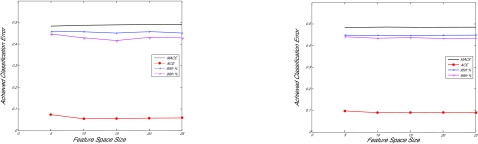
PACE analysis using a SVM-based classifier using the J5 scoring criterion, with a 0.6 MAC threshold. Left Panel: performance without peak selection. Right panel: performance with peak selection.